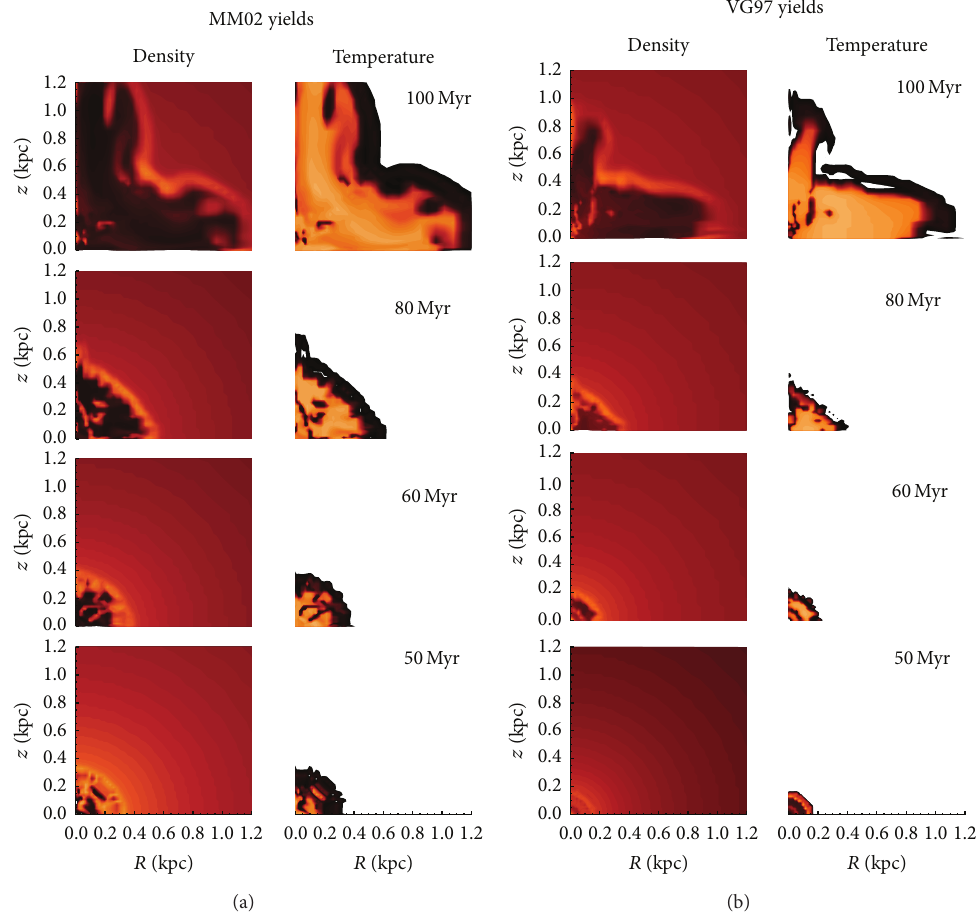
Figure 4: Density and temperature contours at 4 evolutionary times (labelled on each of the right panels) for a model adopting MM02 (a) and VG97 (b) yields, respectively. The (logarithmic) density scale (in gcm −3 ) ranges between − 27 (dark) and − 23 (bright). The (logarithmic) temperature scale (in K) ranges between 3 (white) and 7